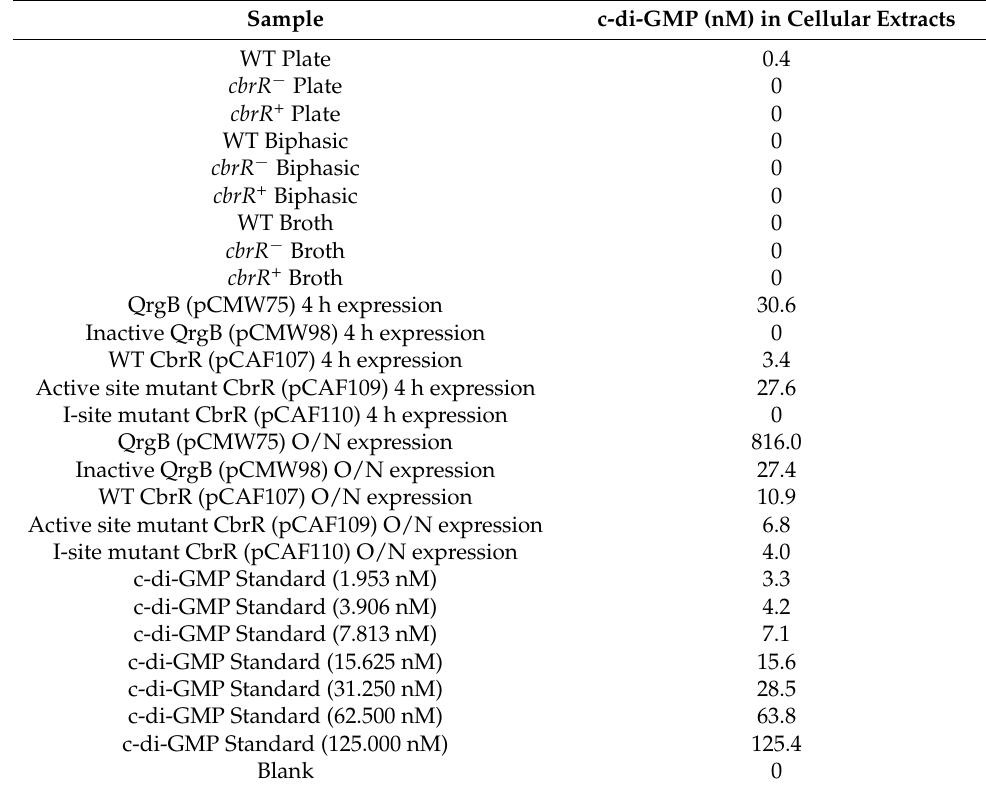
Figure 10. Mutation in the autoinhibitory site of CbrR leads to loss of c-di-GMP binding. Point mutants of cbrR to inactivate the I-site and active site were generated and their ability to bind GTP and c-di-GMP were established in DRaCALA assays. Results show that the CbrR active site mutant binds both GTP and c-di-GMP; however, the I-site mutant lost the capacity to bind c-di-GMP. The diguanylate cyclase Pseudomonas fluorescens WspR is shown as a positive control able to bind both small molecules while Pseudomonas aeruginosa Alg44 is a negative control for GTP binding but a positive control for c-di-GMP binding. Table 1. Detection of c-di-GMP in nucleotide extraction